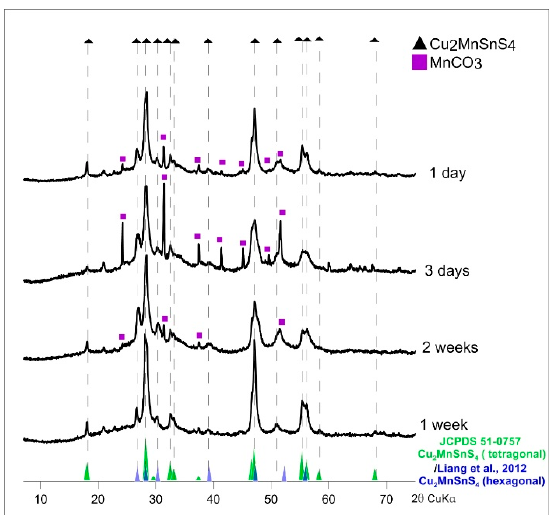
Figure 7. Powder X-ray diffraction patterns of synthetic Cu 2 MnSnS 4 (CMTS) resulting from different synthesis times (synthesis at 195 °C and EG:H 2 O = 7:1). MnCO 3 (rhodochrosite) was detected in the products of syntheses lasting one day and three days and in the product of synthesis at low temperature (160 °C for two weeks).